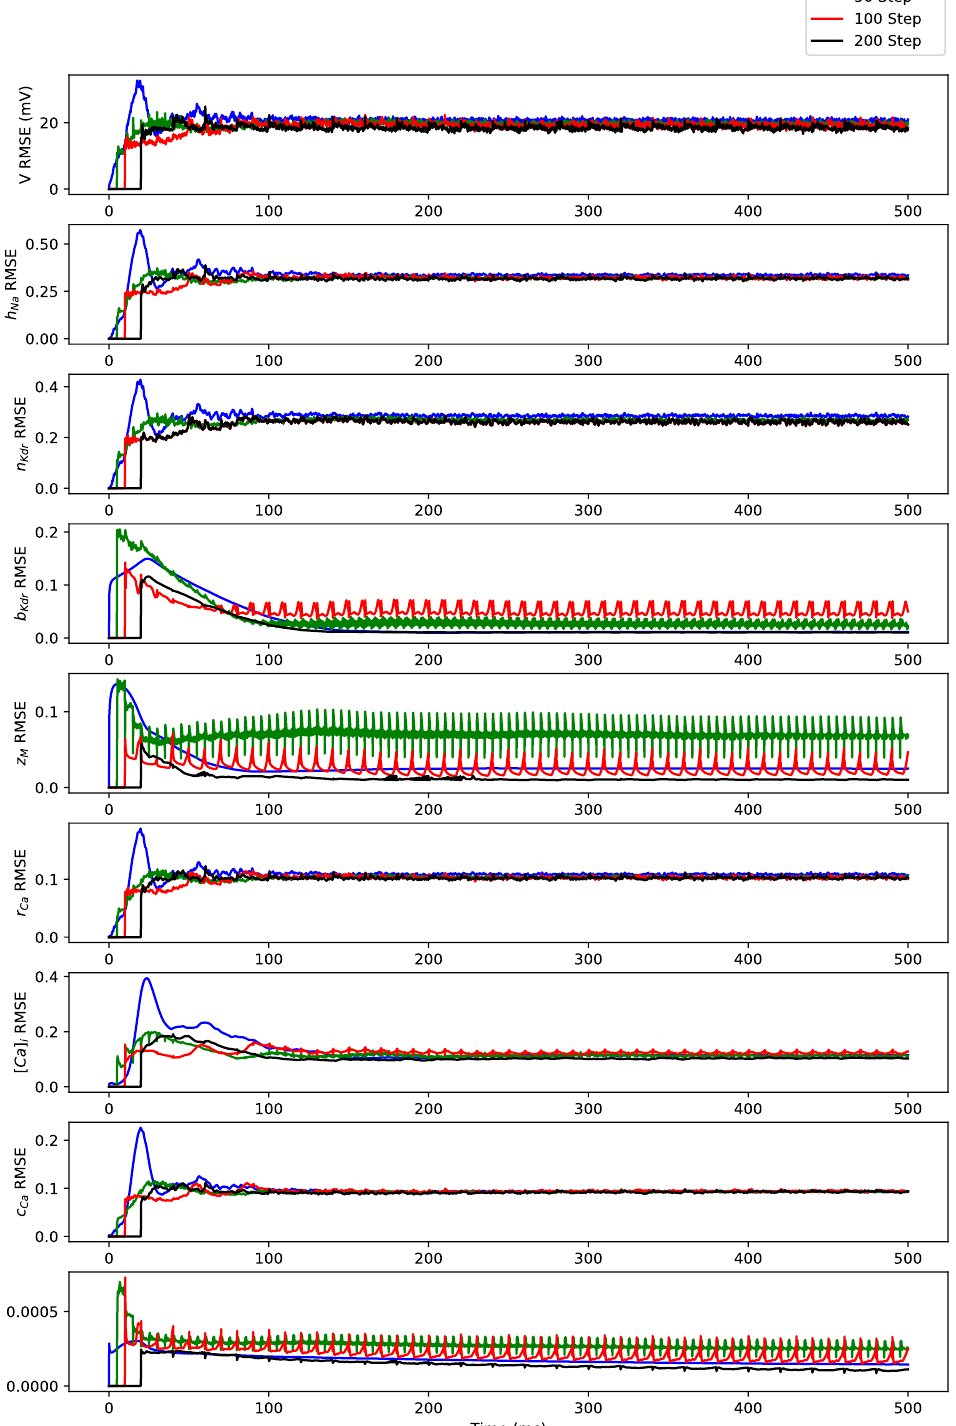
Figure A10. The root mean squared error (RMSE) versus simulation time for 5000 independent realizations, drawn from the predicted membrane potential trajectories of 50 randomly selected stimulating currents from a Uniform distribution U ( 0.79,2.3 ) and 100 random initial conditions for each stimulating